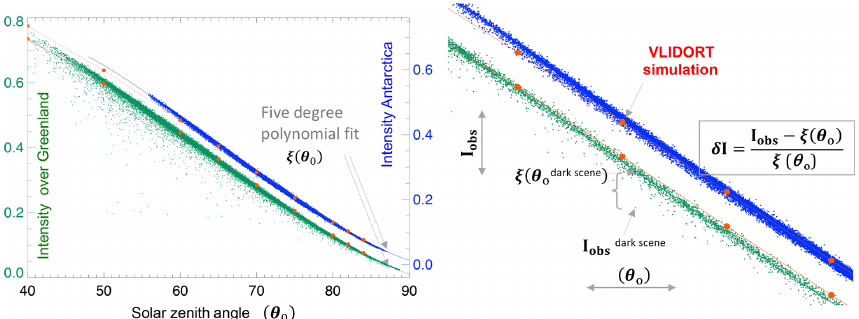
Figure 1. Measured intensity at 340nm from the NOAA-16 SBUV versus solar zenith angle over the Antarctic Plateau (blue) and Greenland (green). Each point is a nadir-viewed observation at the native field of view (170km by 170km) during the summer (15d on either side of solstice). Also shown is a polynomial fit and a radiative transfer simulation (red) assuming a Lambertian surface albedo of 0.95 and a Rayleigh atmosphere with a surface pressure of 663hPa. Note that the Greenland intensities are offset from the Antarctic ones. The right panel shows a zoomed-in view (see text for details).